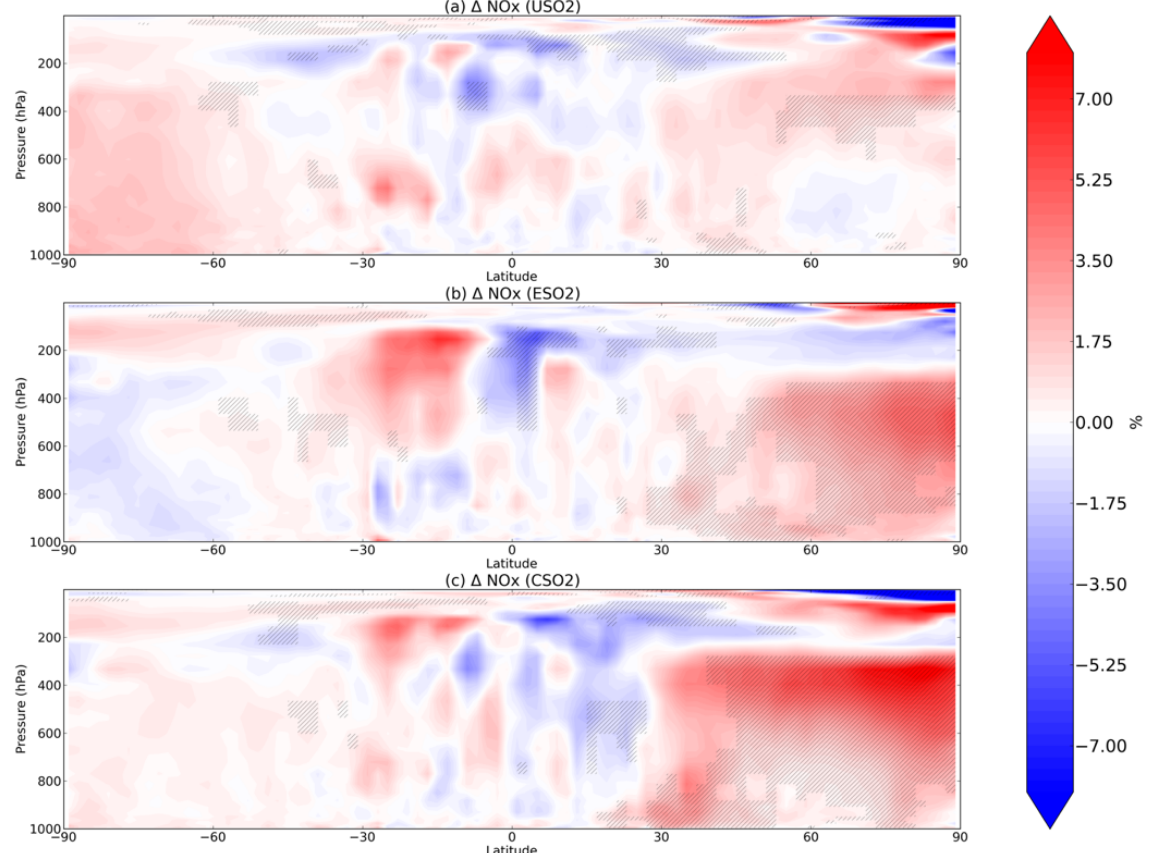
Figure 3. Boreal springtime (MAM) mean percent change in NO x between a control simulation and a perturbation simulation in which anthropogenic SO 2 emissions are removed over a certain region: (a) US, (b) Europe, and (c) China. Hatching denotes statistical significance according to a Student’s t test at the 95% confidence